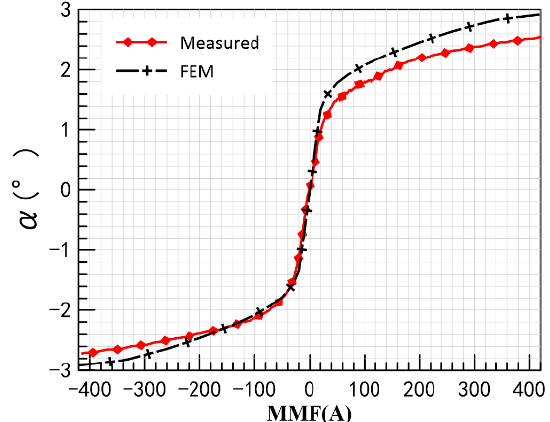
Figure 28. MMF_actual rotation angle.